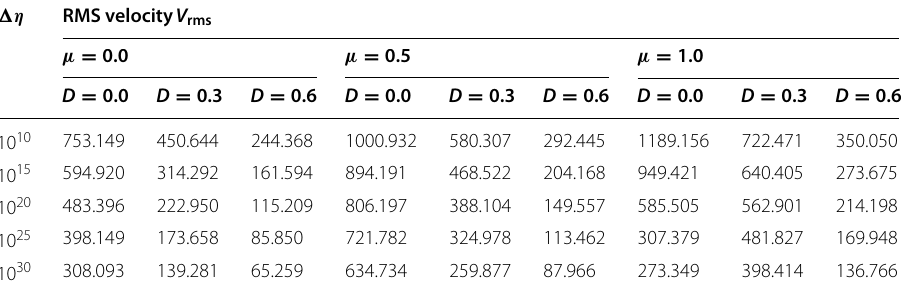
Table 5 RMS velocity V rms computed for µ = 0.0 , µ = 0.5 , µ = 1.0 with different viscous dissipation number D at Ra = 10 7 and θ 0 =